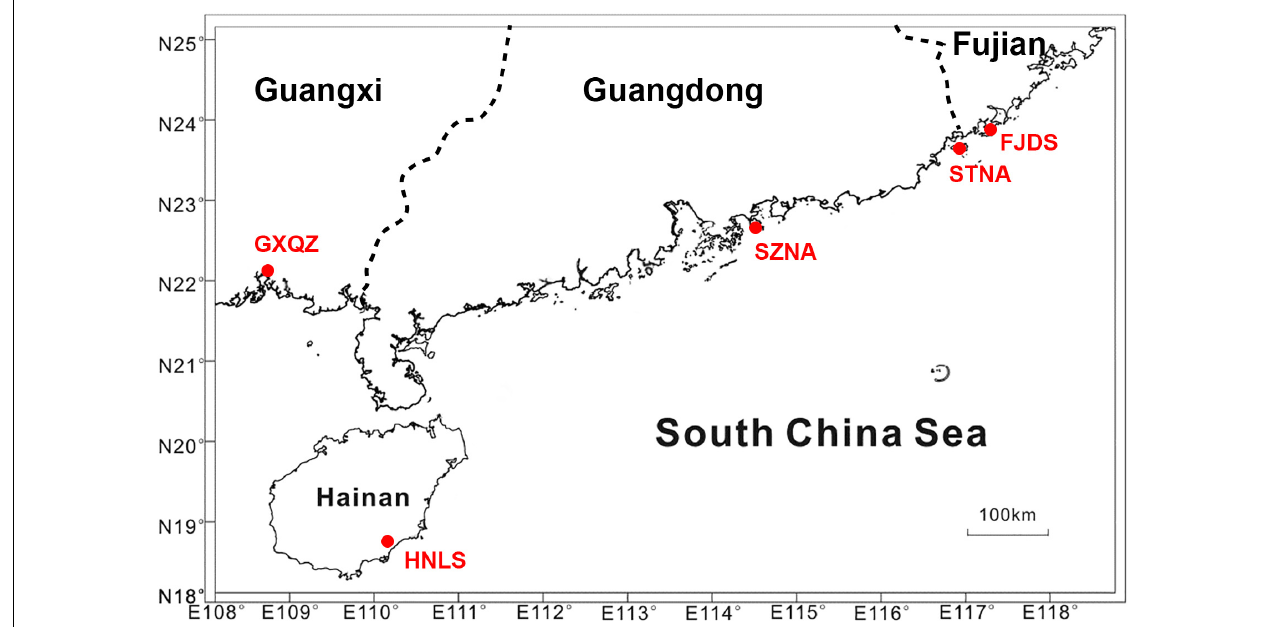
FIGURE 1 | Sampling locations of wild and cultured Chlamys nobilis populations in South China.